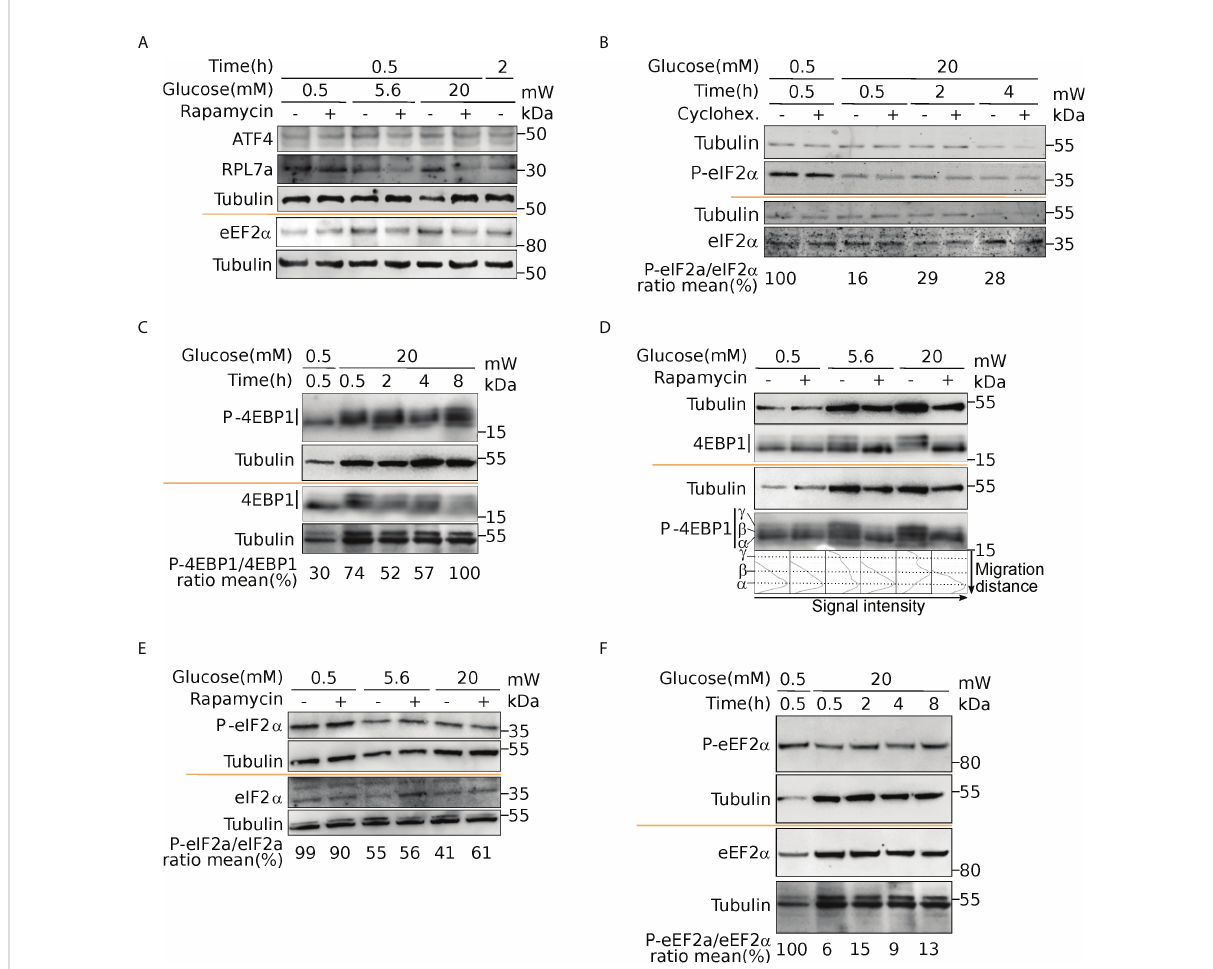
FIGURE 7 Activation of mTOR and eIF2 a upon glucose induction. Western blot analysis of ATF4 and RPL7a (A), eEF2 a and P-eEF2 a (A, F), eIF2 a and P- eIF2 a (B, E), 4EBP1 and P-4EBP1 (C, D). Cells were incubated with 0.5- or 20-mM glucose for the indicated time. Where indicated, cells were pre-treated for one hour with cycloheximide (CHX) to block translation, or with rapamycin to inhibit mTOR activation (see text). For 4EBP1, upper bands (b and g) correspond to hyperphosphorylated forms. The ratio phosphorylated/total proteins was reported from quanti fi cation presented in Figure